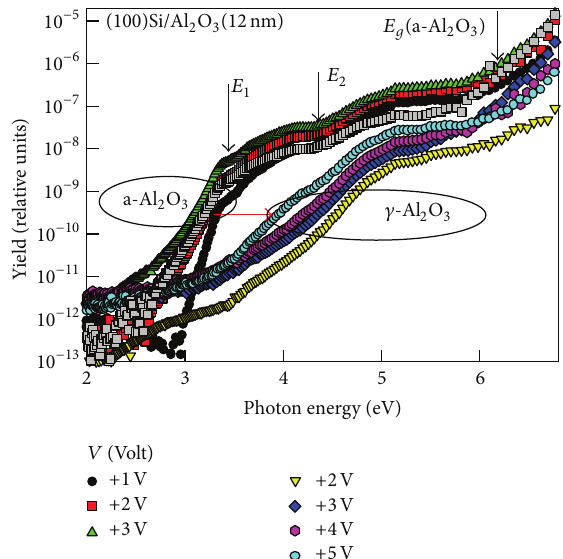
Figure 4: Semilogarithmic plot of the quantum yield of electron IPE from Si as a function of photon energy measured on Si/Al 2 O 3 /Au samples with an as-deposited 12nm thick amorphous (a) ALD Al 2 O 3 layer, as compared to the polycrystalline ( 𝛾 -phase) Al 2 O (same samples) obtained by annealing at 1000 ∘ C (filled